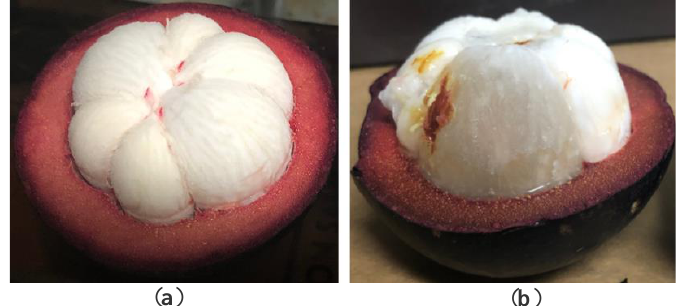
Figure 11. Mangosteen flesh; ( a ) Normal flesh; ( b ) Translucent flesh.